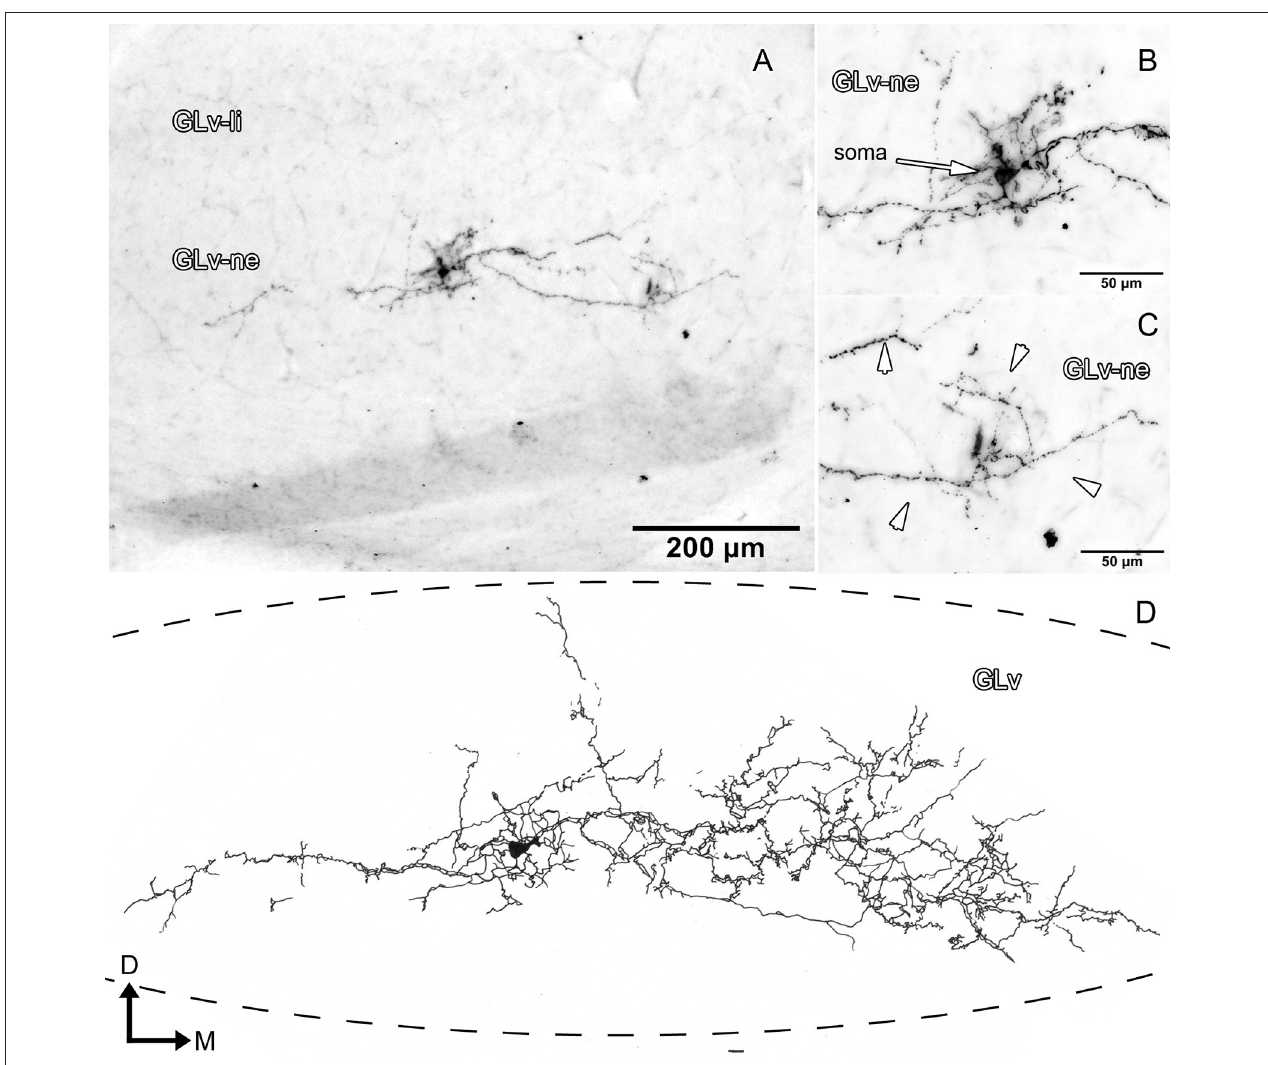
FIGURE 5 | Intracellular filling of a representative GLv-ne type III cell. (A–C) Photomicrographs showing the neuronal extension, soma location, and dendritic processes (white arrowheads). (D) Reconstruction of the biocytin-filled neuron. D, dorsal; M, medial. Orientation in (D) applies to (A–C)